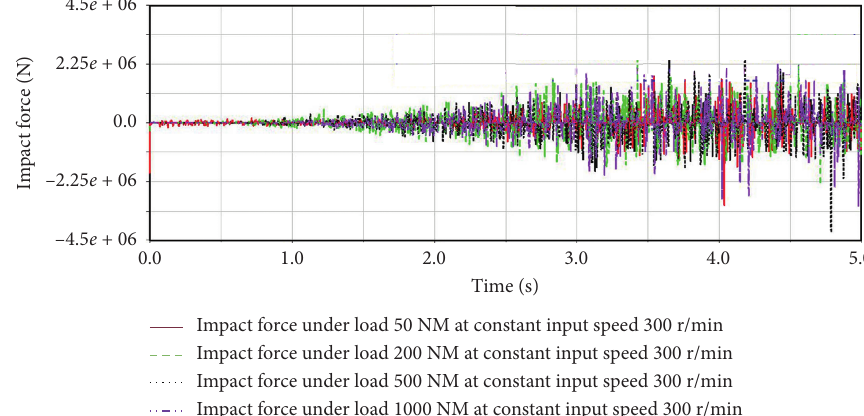
Figure 14: Impact force of second-stage face gear pair under variable load.